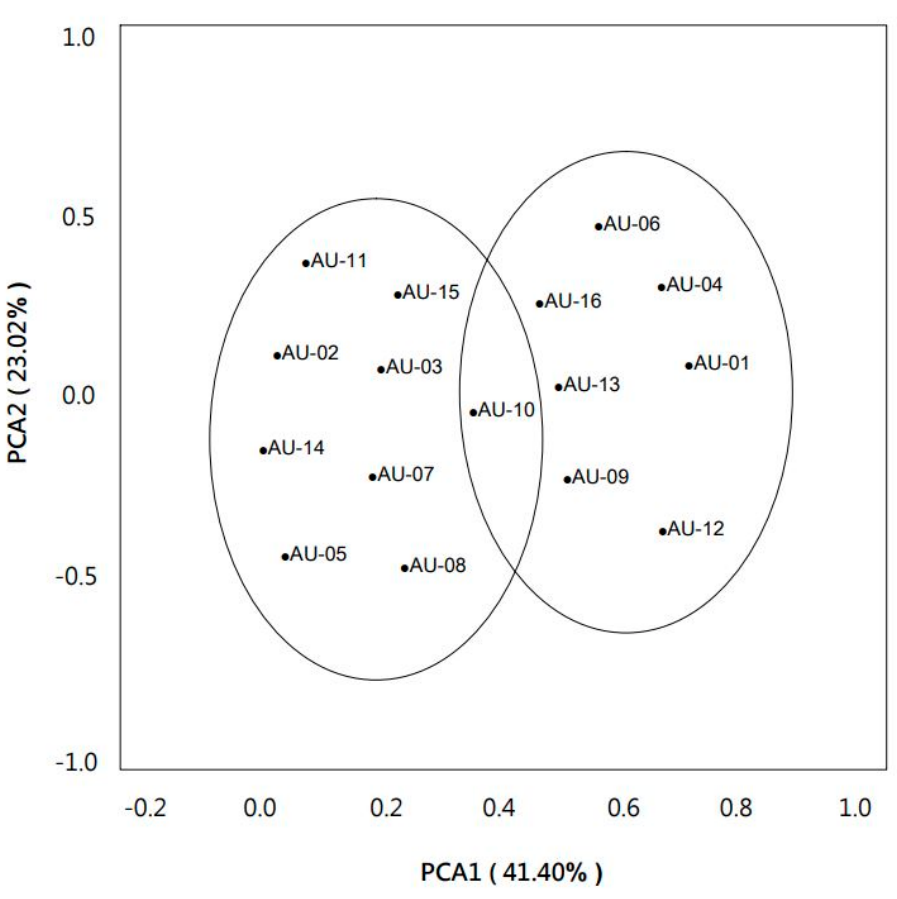
Figure 1. Scatter plot graphs showing the relationships between 16 individual strawberry tree genotypes based on morphological and biochemical data .